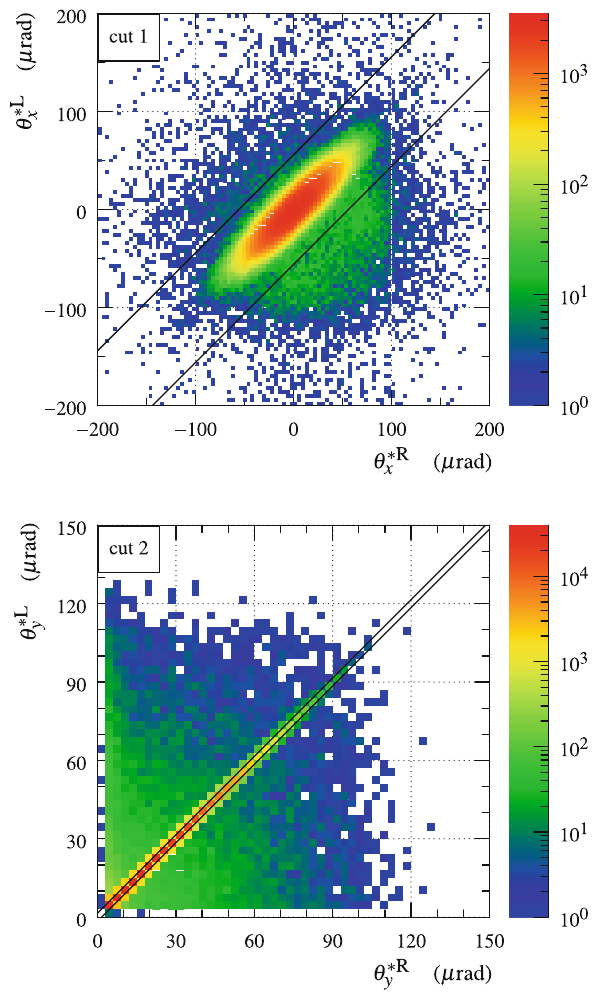
Fig. 4 Correlation plots for the elastic event selection cuts presented in Table 2 (“2RP” analysis), showing events from the LHC fill 5313 and with diagonal topology 45 bottom–56 top. The solid black lines delimit the signal region within ± 4 σ